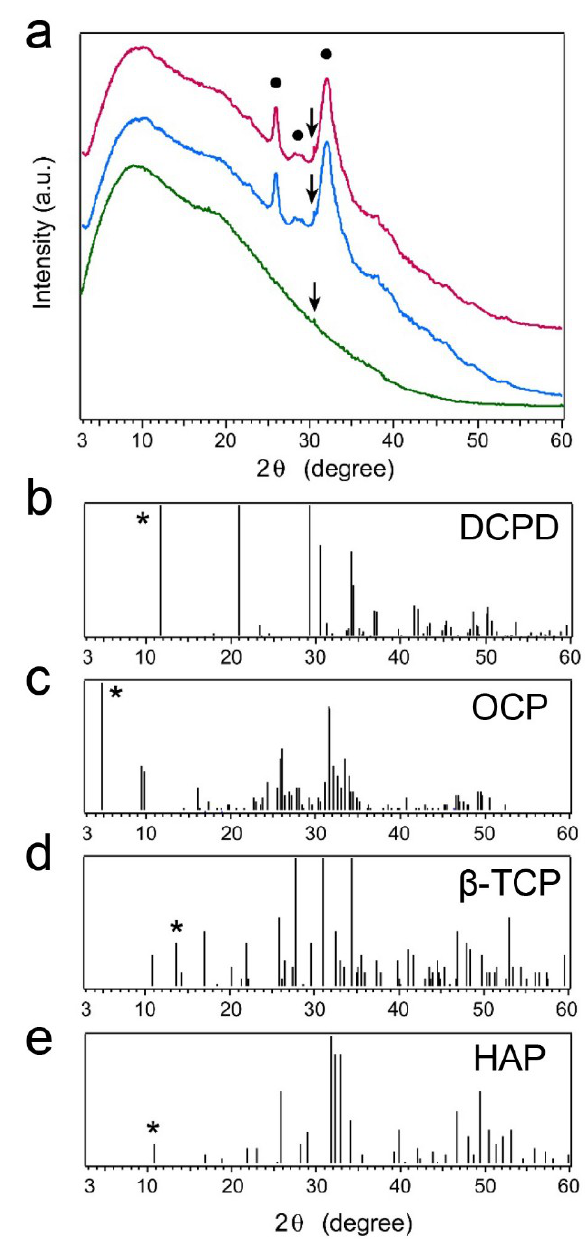
Figure 5. ( a ) Microbeam XRD patterns for samples grown with (magenta curve) and without (blue curve) MDZ in culture solution and for a cell sheet (green curve) for reference. Peaks attributed to the precipitates are indicated by black circles; spike peaks attributed to damage to the imaging plate are indicated by arrows. Ideal XRD patterns for ( b ) dicalcium phosphate dihydrate (DCPD), ( c ) octacalcium phosphate (OCP), ( d ) β -tricalcium phosphate ( β -TCP), and ( e ) hydroxyapatite (HAP) derived using 2 θ versus diffraction–intensity relationships in the corresponding JCPDS cards. The peaks used to identify each calcium phosphate phase are indicated by asterisks.